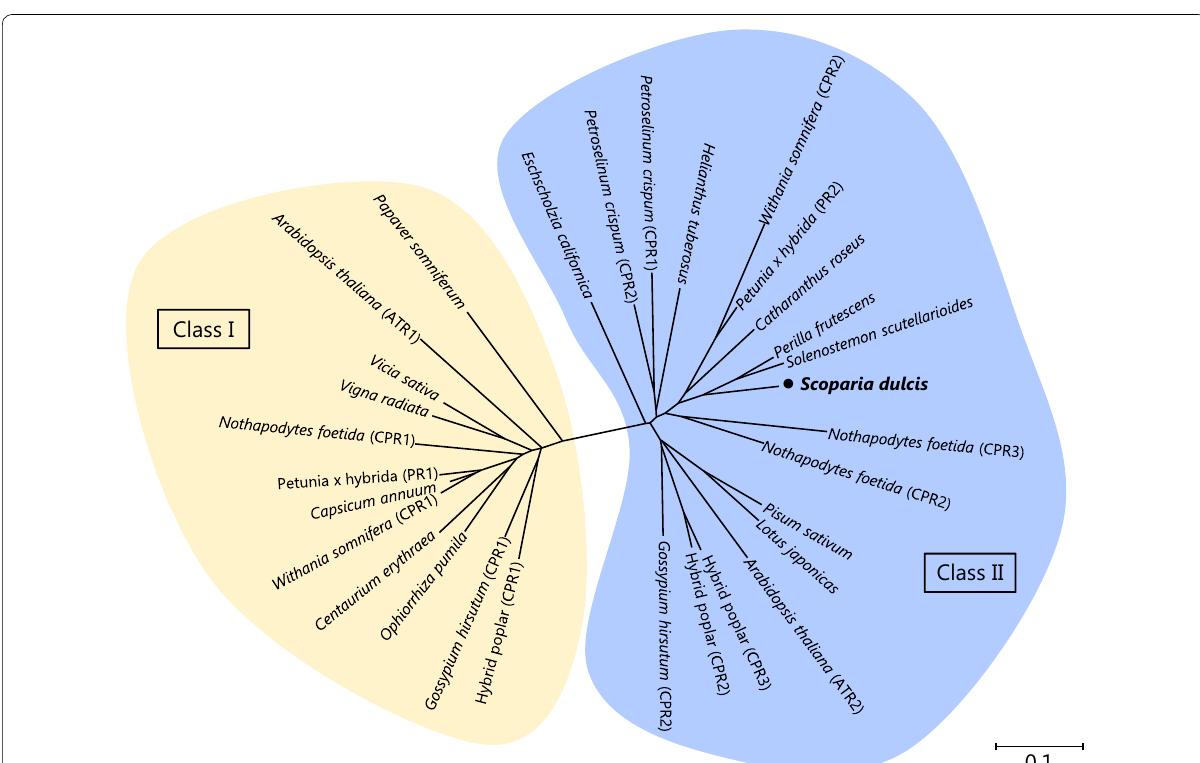
Fig. 2 Phylogenetic trees of SdCPR. The maximum likelihood trees illustrate the phylogenetic relatedness of SdCPR with other CPRs. Descriptions of CPRs used in the phylogeny are listed in Additional file 1: Table S2. Phylogenetic analyses were performed using the neighbor-jointing method using Genetyx ver.14 software. The scale bar indicates the number of amino acid substitutions per site